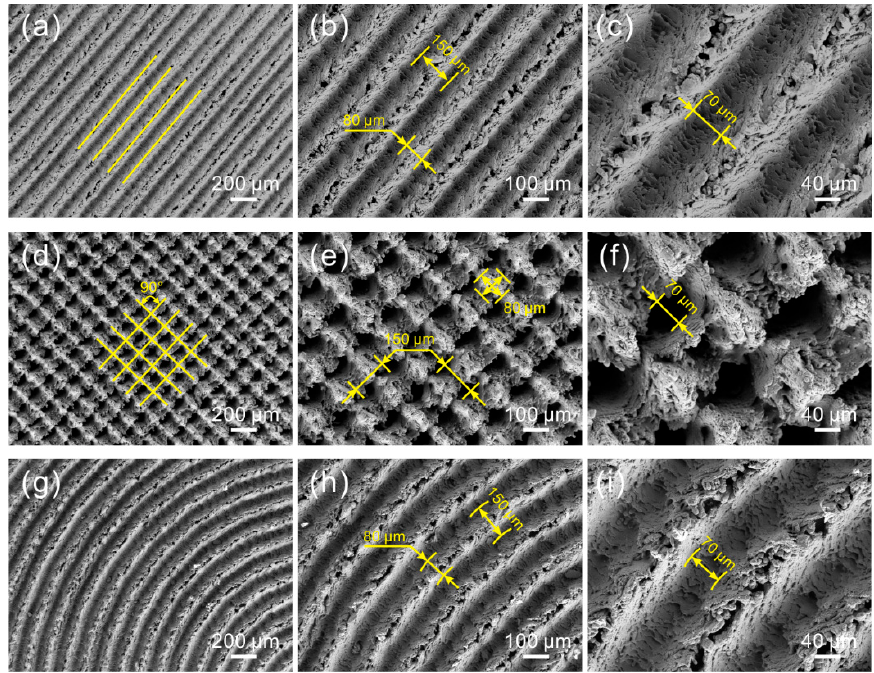
Figure 2. SEM images of the morphology of the Al alloy micro-scale structure surfaces (texture spacing of 150 μ m): ( a ) linear groove, ( d ) gridding groove, ( g ) arc groove; ( b , c , e , f , h , i ) corresponding high-magnification SEM images.